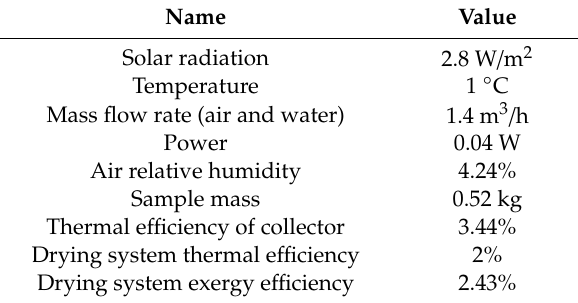
Table 3. Di ff erent experimental variables’ uncertainty